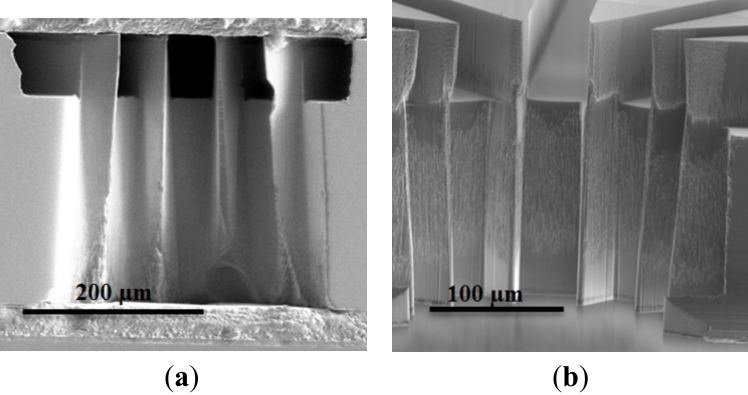
Figure 6. Cross section view (scanning electron microscope (SEM)) of the nozzle chip fabricated with old process P0 described in [15] ( a ), and cross section view (SEM) of the nozzle chip fabricated with enhanced process P1 described below ( b